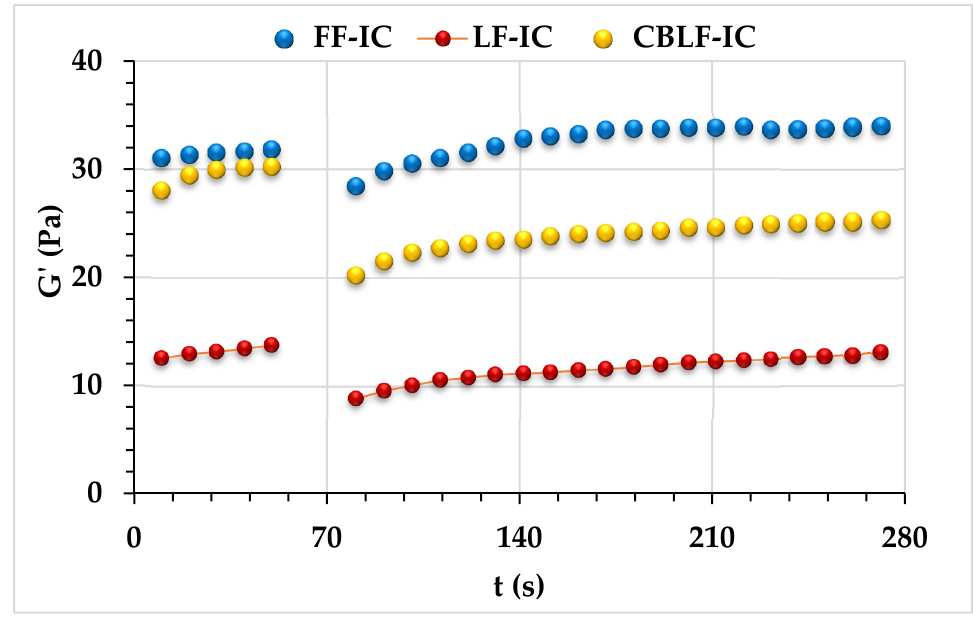
Figure 5. 3-ITT rheological properties of ice cream mixes. FF-IC: full-fat ice cream, LF-IC: low-fat ice cream, CBLF-IC: low-fat ice cream with chia seed oil by-product.